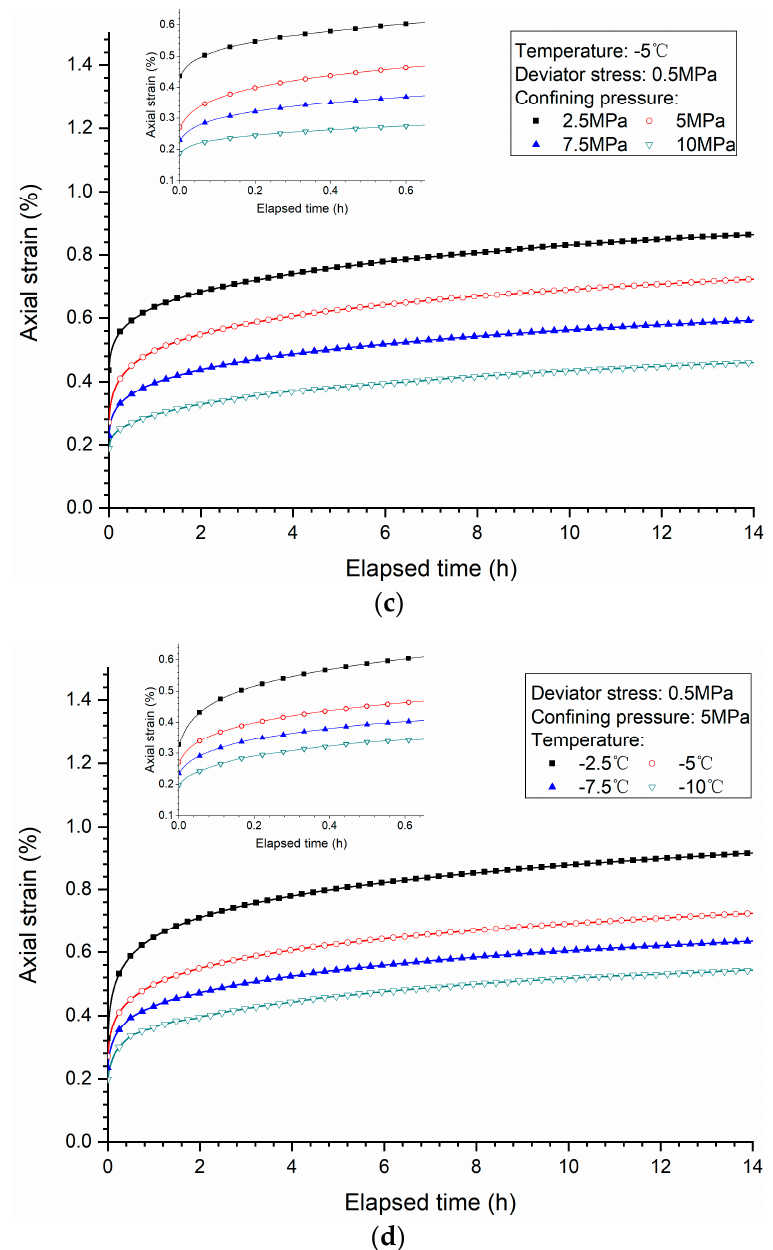
Figure 2. The creep curves of methane hydrate-bearing frozen specimens under different ( a ) low deviator stresses; ( b ) high deviator stresses; ( c ) confining pressures; and ( d ) temperatures.